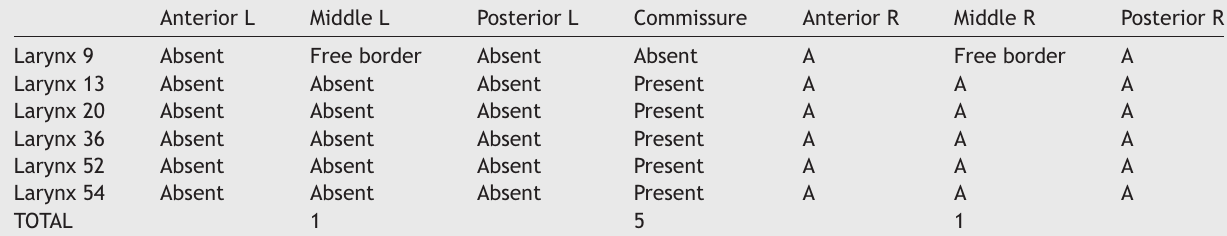
Distribution of the six alterations found according to their location in the anterior, middle, and posterior thirds of the membranous portion of the vocal folds, left and right, anterior commissure, upper and lower portion, and free border of the vocal folds ( n = 56).